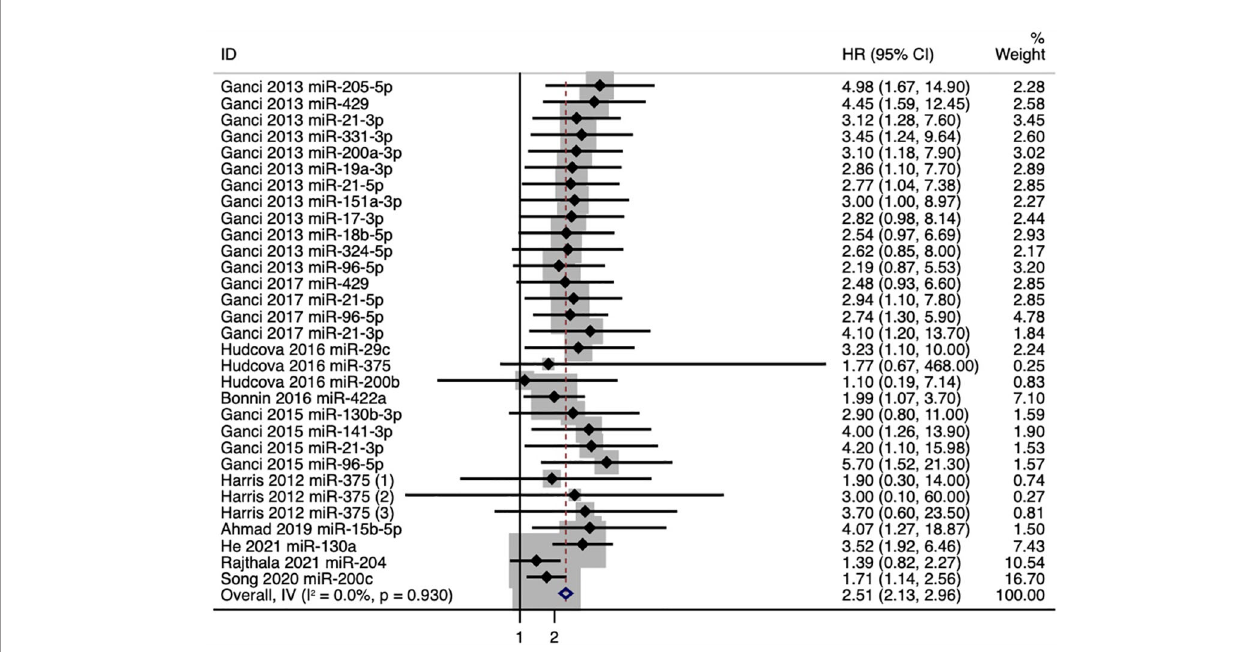
FIGURE 2 | Forest plot for the association between microRNA expression and recurrence-free survival (RFS).